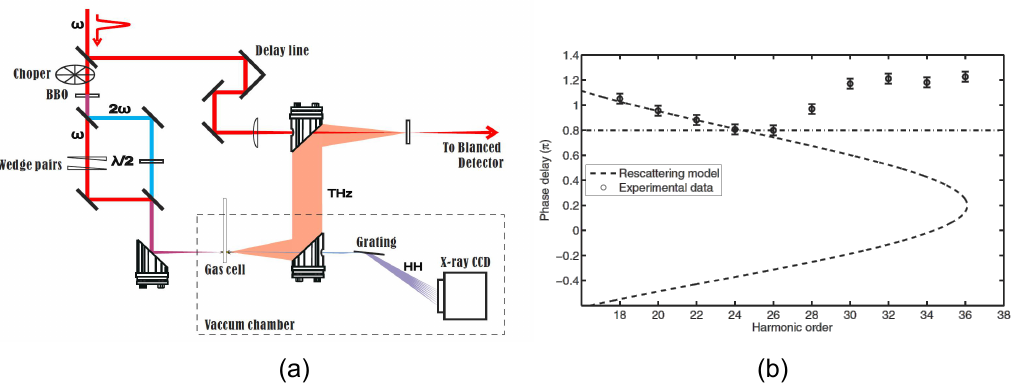
Figure 2. ( a ) Typical experimental set-up for HATS generation and detection. ( b ) The experiment obtained optimal phase for even-harmonics (circles) are compared to the semiclassical calculation (dashed line). Optimal phase for THz yield is locked at 0.8 π (dotted dashed line). Reproduced with permission from [18]. Copyright IOP Publishing,